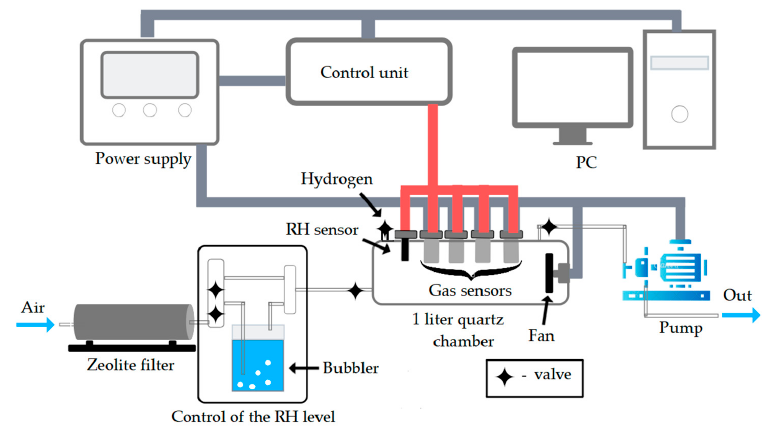
Figure 4. The schematic block diagram of the measuring stand.